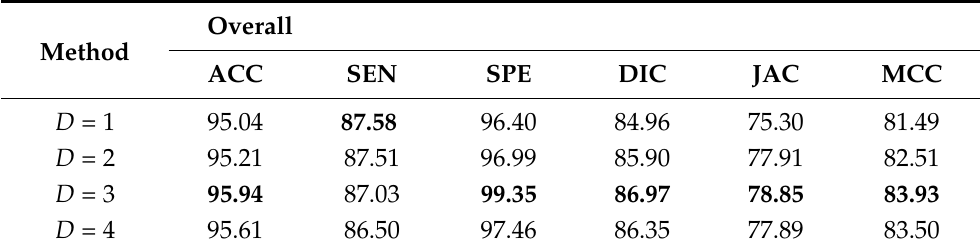
Table 2. Determination of the number D of densely connected blocks on the ISIC-2017 data set. Bold data indicates that the value is the maximum value in this